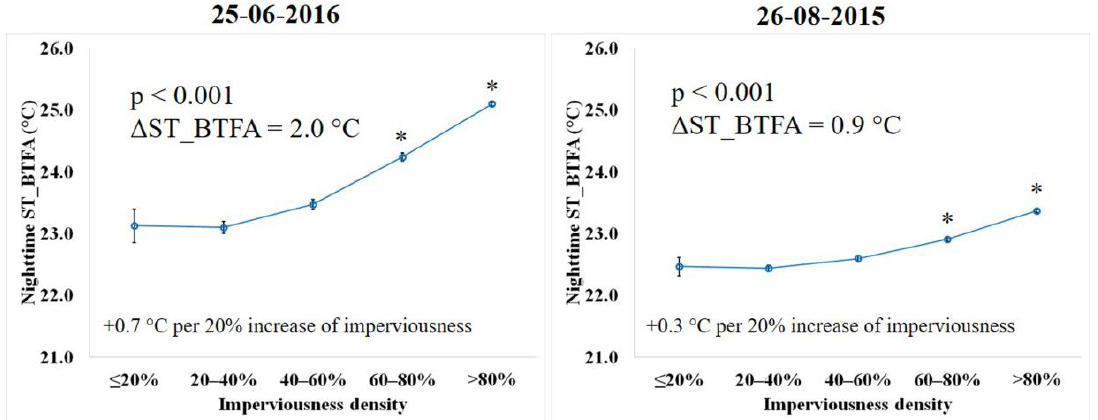
Figure 4. Relationships between nighttime mean surface temperatures nearby residential buildings (ST_BTFA) and imperviousness density (ID) groups on two summer days in Parma. ΔST_BTFA represents the difference between the highest and the lowest nighttime mean ST_BTFA among ID groups. The 95% confidence intervals for ST_BTFA means are indicated. The p value was assessed by using the Kruskal–Wallis test. * indicates significant daytime ST_BTFA differences ( p < 0.01) compared with all the other ID groups assessed with the Mann–Whitney U test.